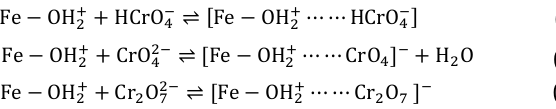
O nano-powder at 298 2 3